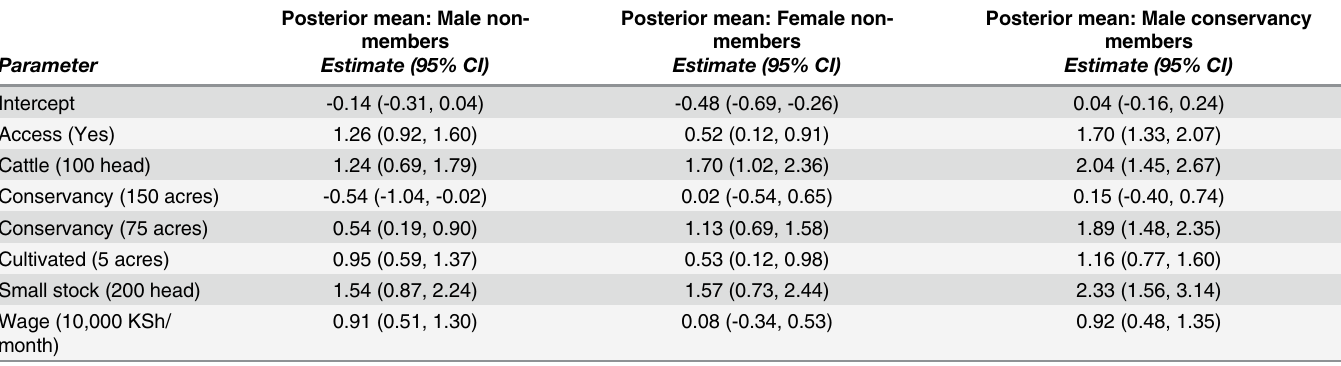
Table 4. Parameter estimates from Model